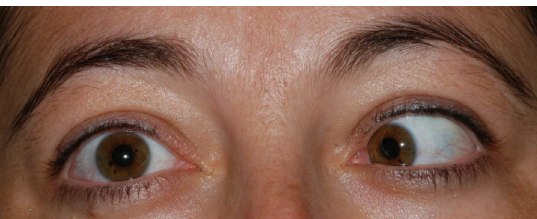
Figure 2: The patient had a restricted right gaze that revealed a right abducens